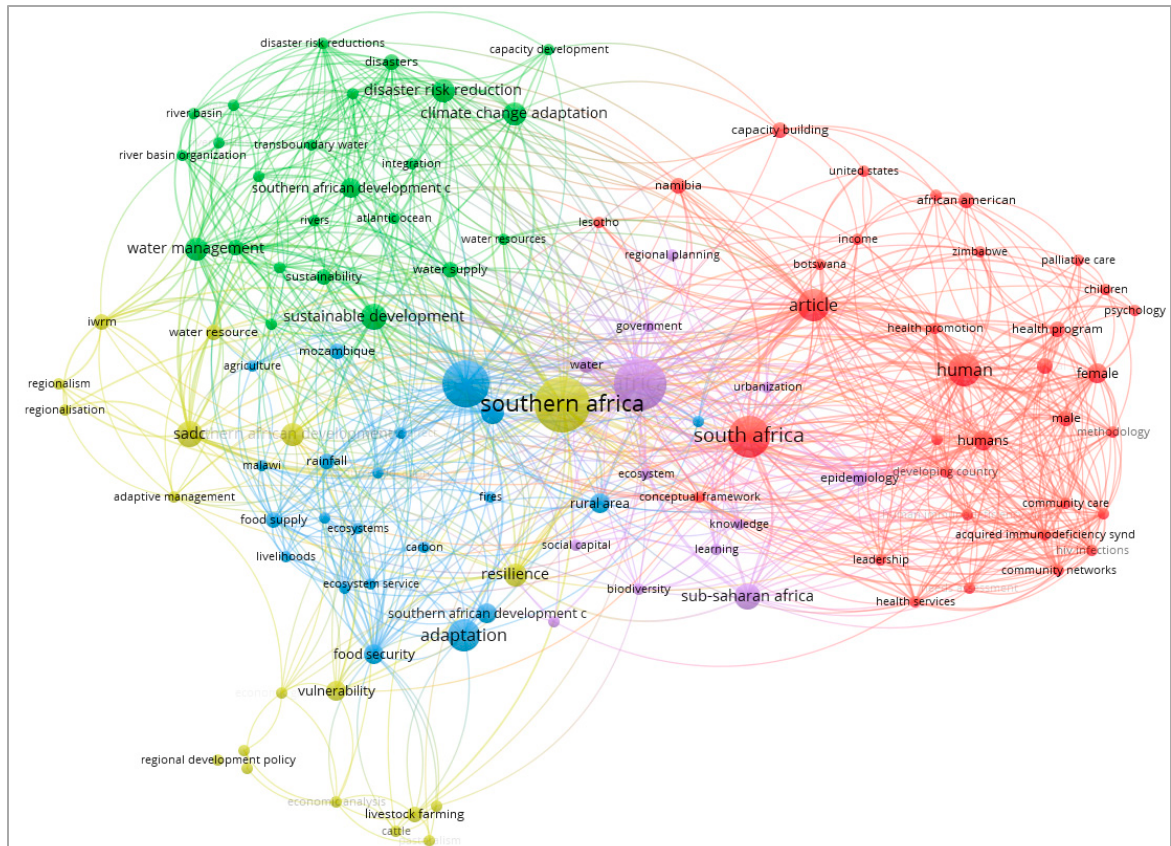
Figure 2. Clusters in SADC resilience